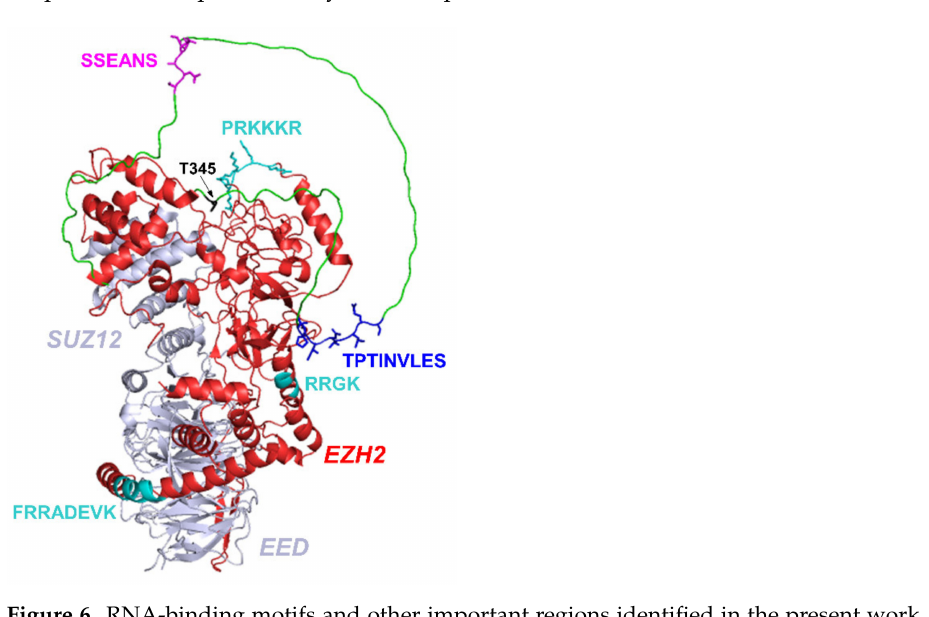
Figure 6. RNA-binding motifs and other important regions identified in the present work. PRC2 crystal structure (PDB: 5LS6) includes SUZ12, EED (grey), and EZH2 (red) [6]; disordered